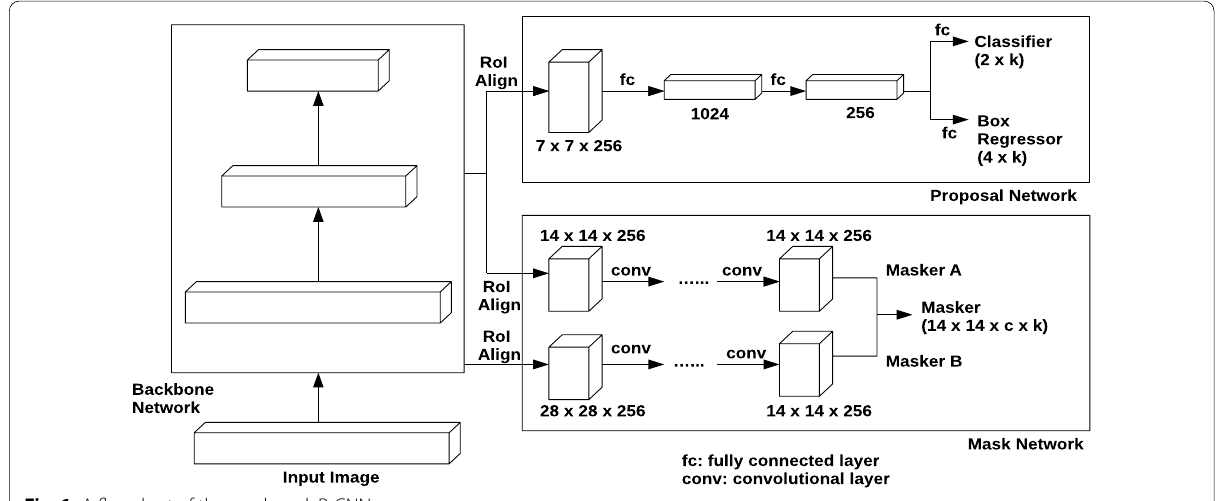
Fig. 1 A flowchart of the used mask